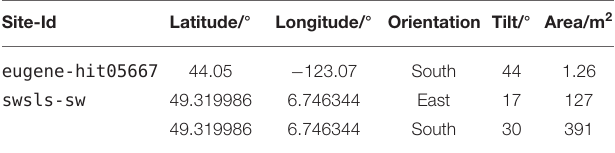
TABLE 3 | Model parameters per